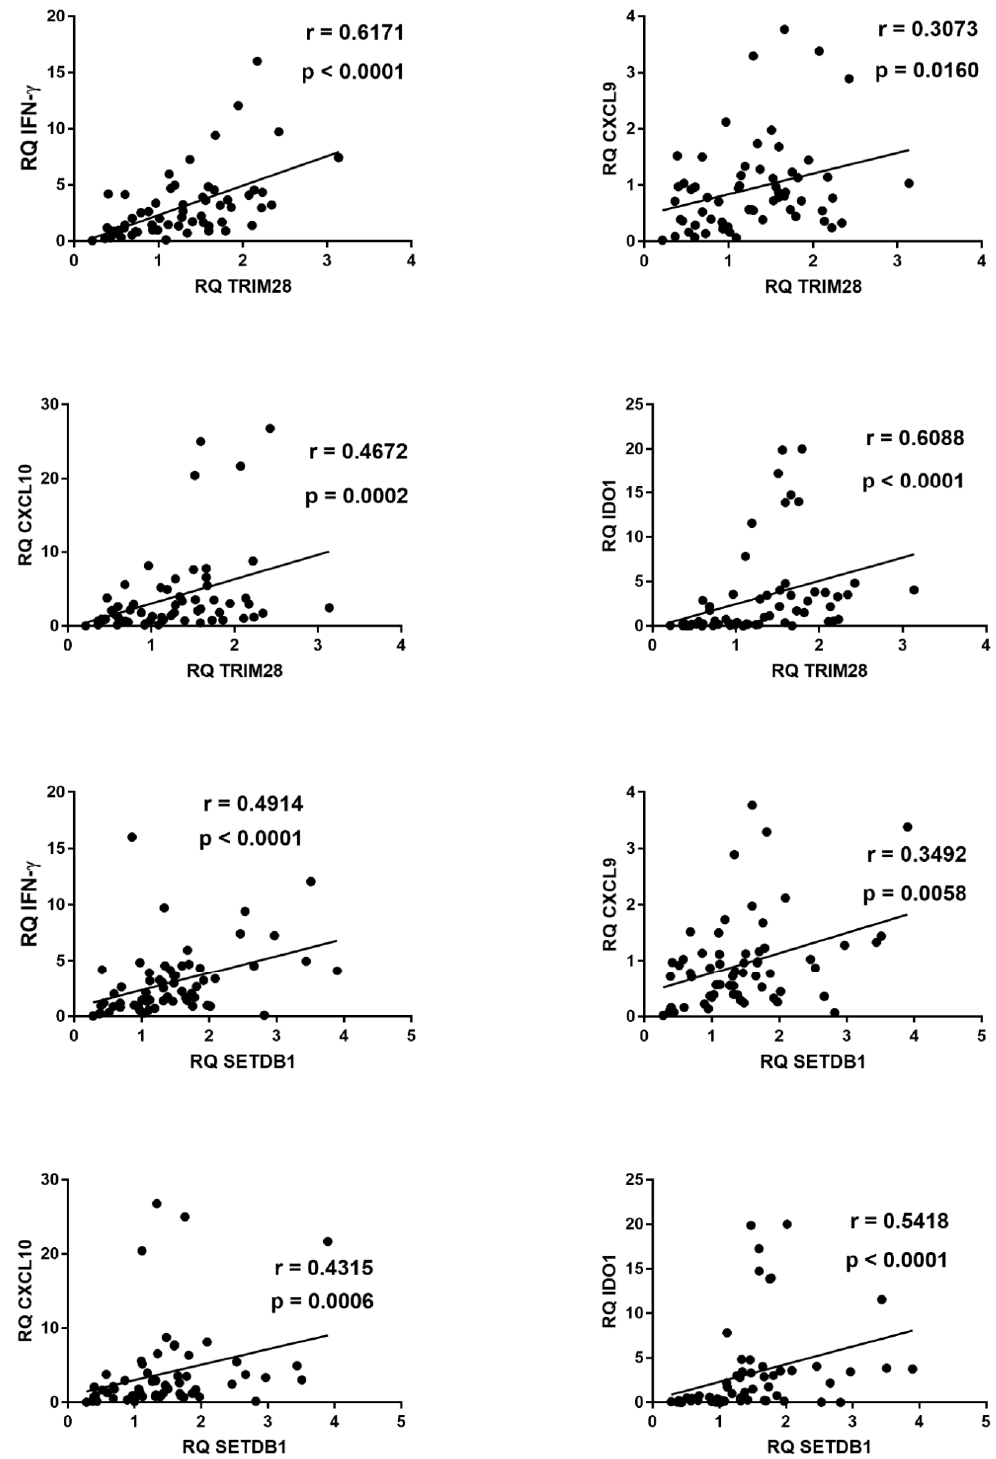
Figure 7. Correlations between transcription levels of type II IFN and its sensitive genes and TRIM28 or SETDB1 in whole blood from 64 COVID-19-infected children. RQ: relative quantification. Circles show the mean of three individual measurements. Line: linear regression line. Statistical analysis: Spearman correlation test.